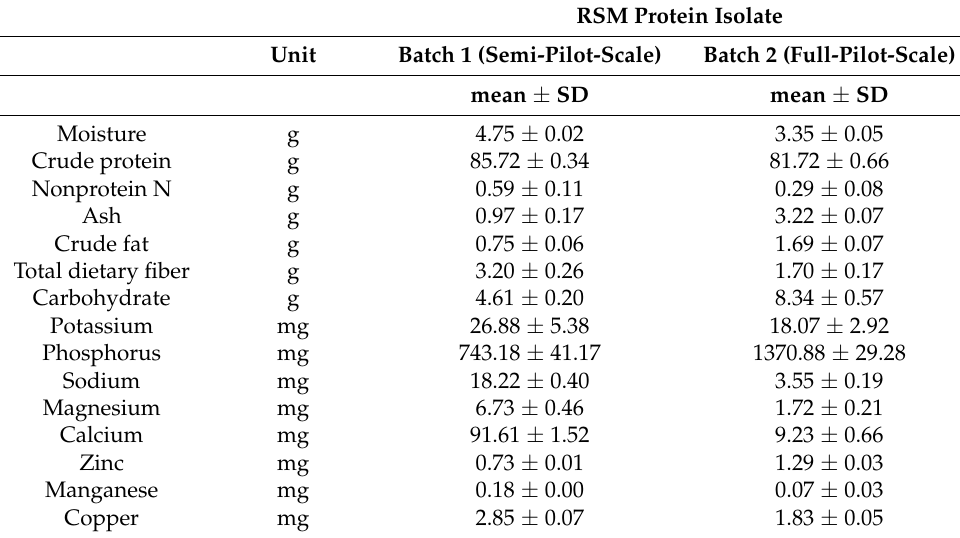
Table 1. Macronutrient and mineral composition of rapeseed meal (RSM) protein isolate from semi-pilot- and full-pilot-scale trials. Values expressed per 100 g of product.